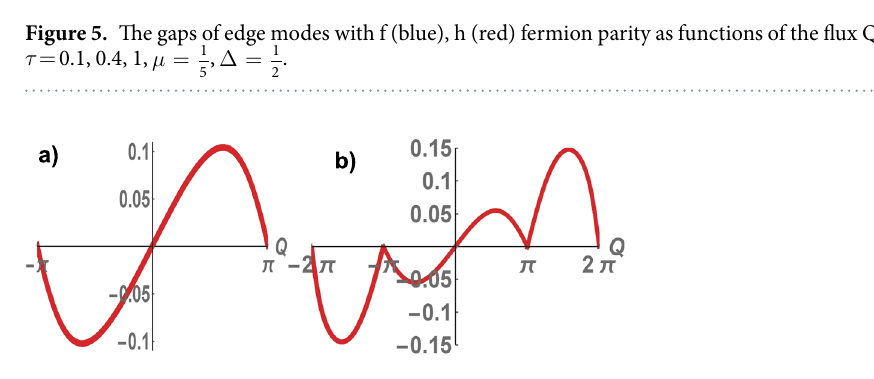
, ∆ = 1 . A 2 π -periodic persistent current in the 5 2 7 ( a ), a 4 π -periodic persistent current in the regime of weak c 10